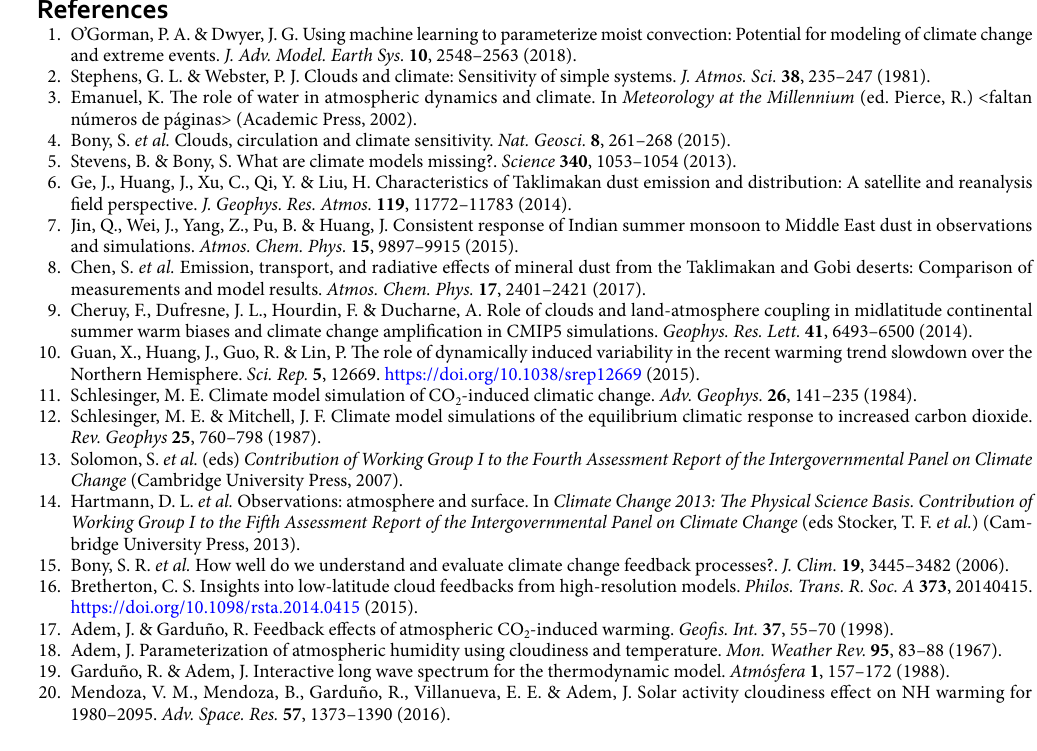
Figure 6. Correlation between the total cloud cover of the CLARA-A2.1 database shown in Fig. 3 and the absolute surface air temperature; in this case the finite increment of ε is ε = − 0.0265K − 2 = 0.29 linear correlation ( R ) as that shown in part (c) of the Fig.